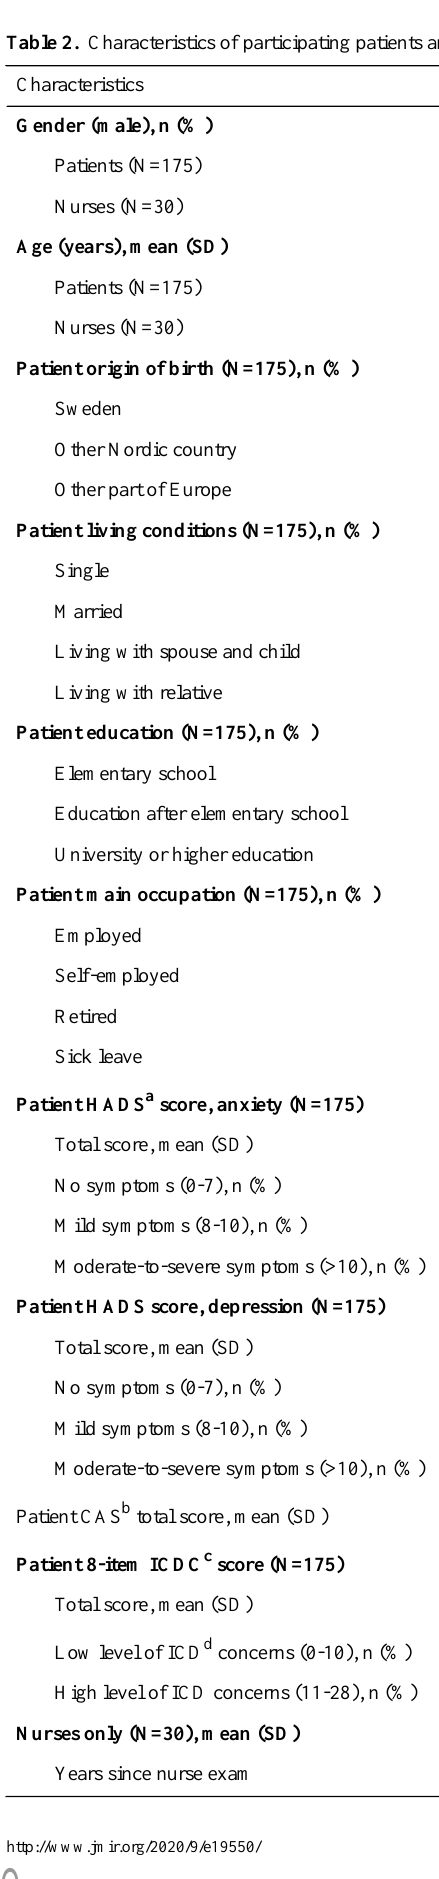
Table 2. Characteristics of participating patients and